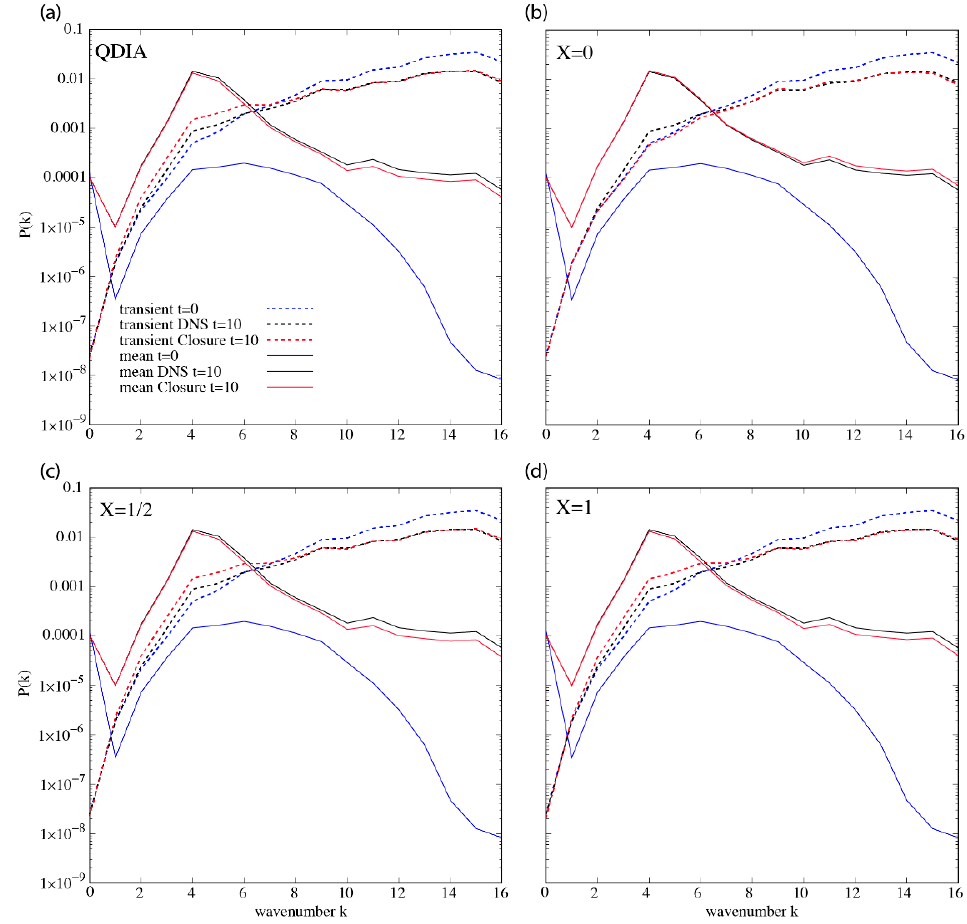
Figure 3. As in Figure 2 for ( a ) QDIA [ ζ ( t )] , ( b ) MIC X = 0 [ ζ ( t )] , ( c ) MIC X = 1 2 [ ζ ( t )] , ( d ) MIC X = 1 [ ζ ( t )] palinstrophy spectra, and the ensemble of DNS on each figure part.